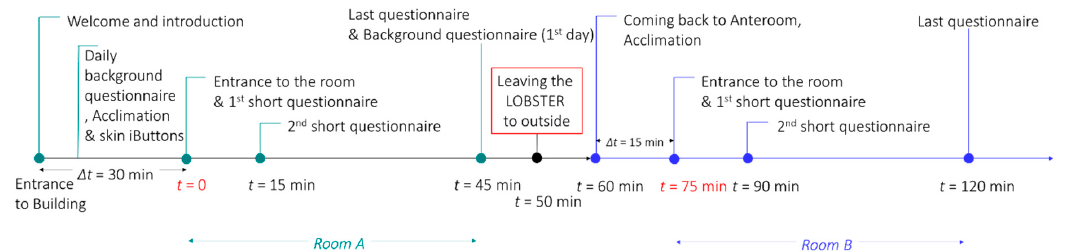
Figure 4. Timeline for experiments and questionnaires.